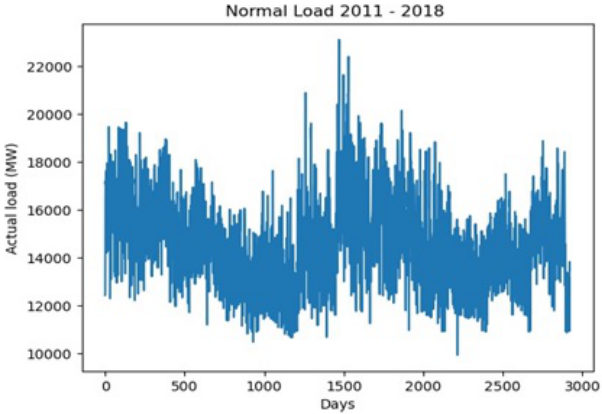
Figure 8. Normal data for eight